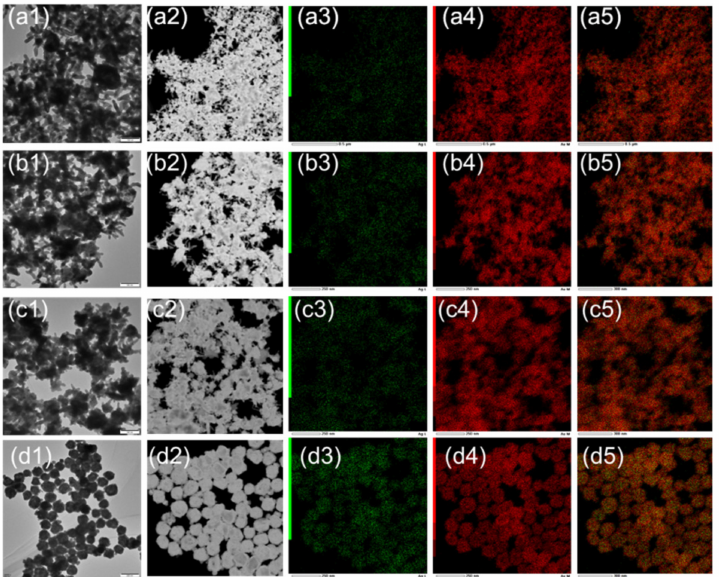
Figure A1. TEM, HAADF, and EDS characterization of the prepared nanoparticles with different amounts of Ag seeds: ( a1 – a5 ) 40 µ L, ( b1 – b5 ) 80 µ L, ( c1 – c5 ) 160 µ L, and ( d1 – d5 ) 500 µ